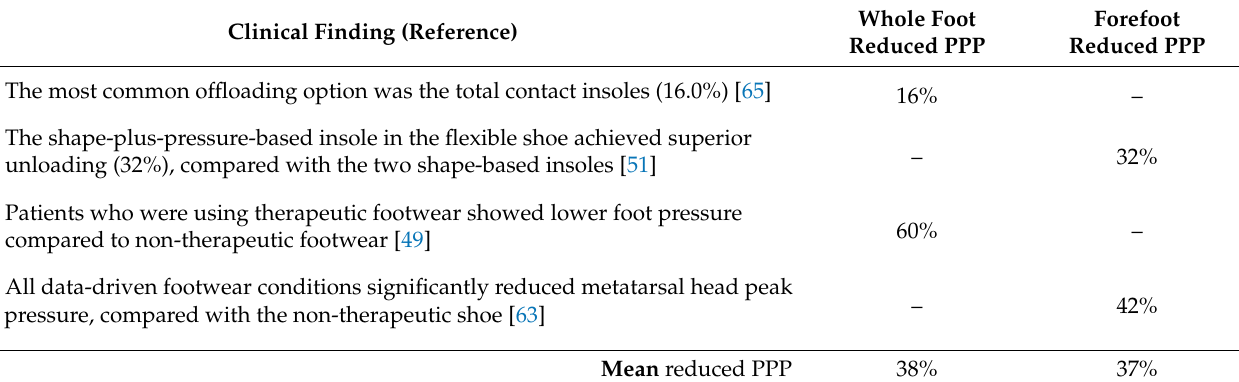
Table 5. EVA insole materials reduce the PPP in the plantar